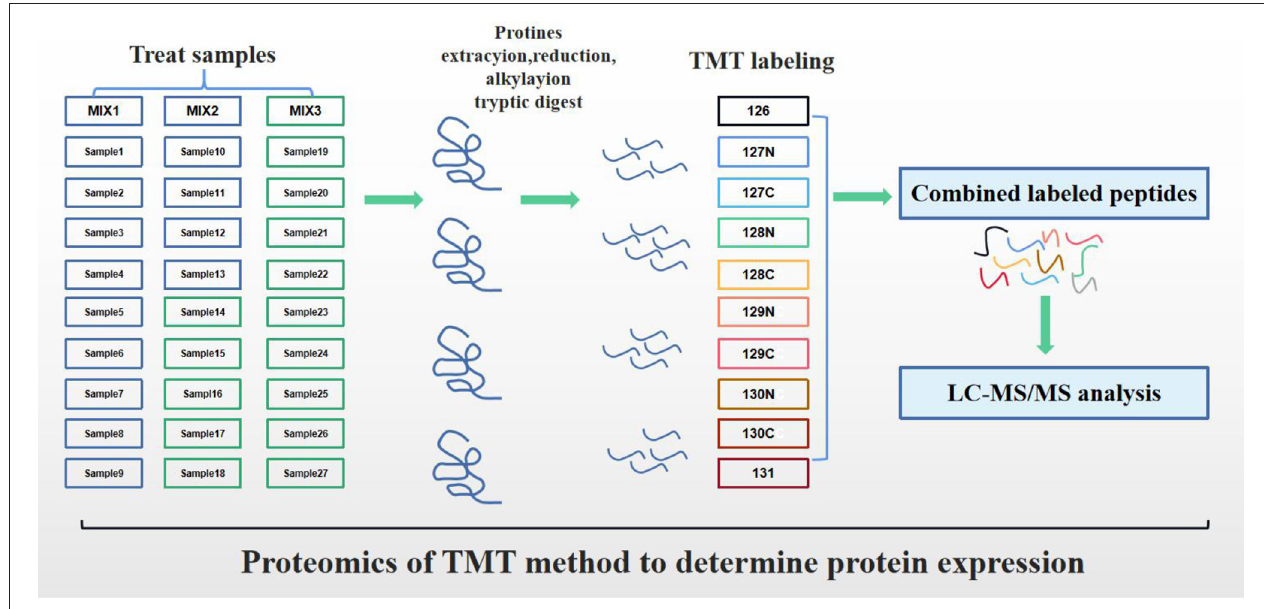
FIGURE 1 | Experimental workflow for proteome